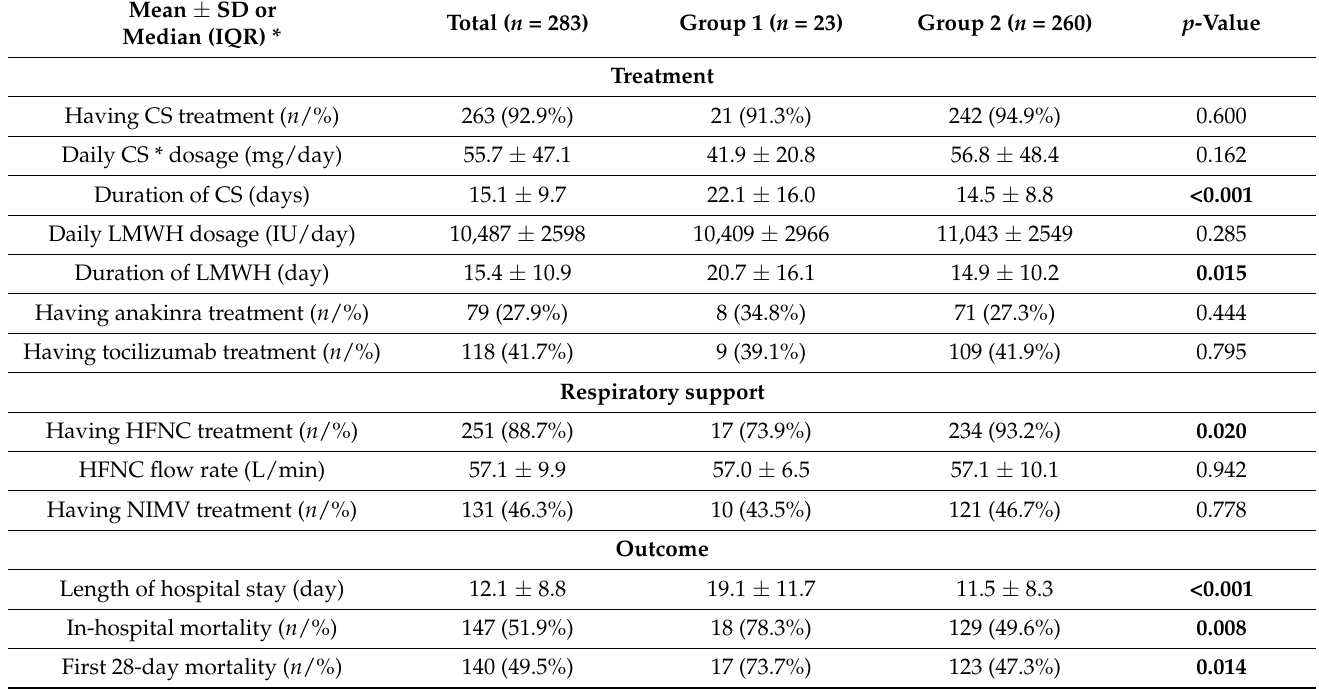
Table 3. Treatment and outcome-related characteristics of the groups according to the presence of